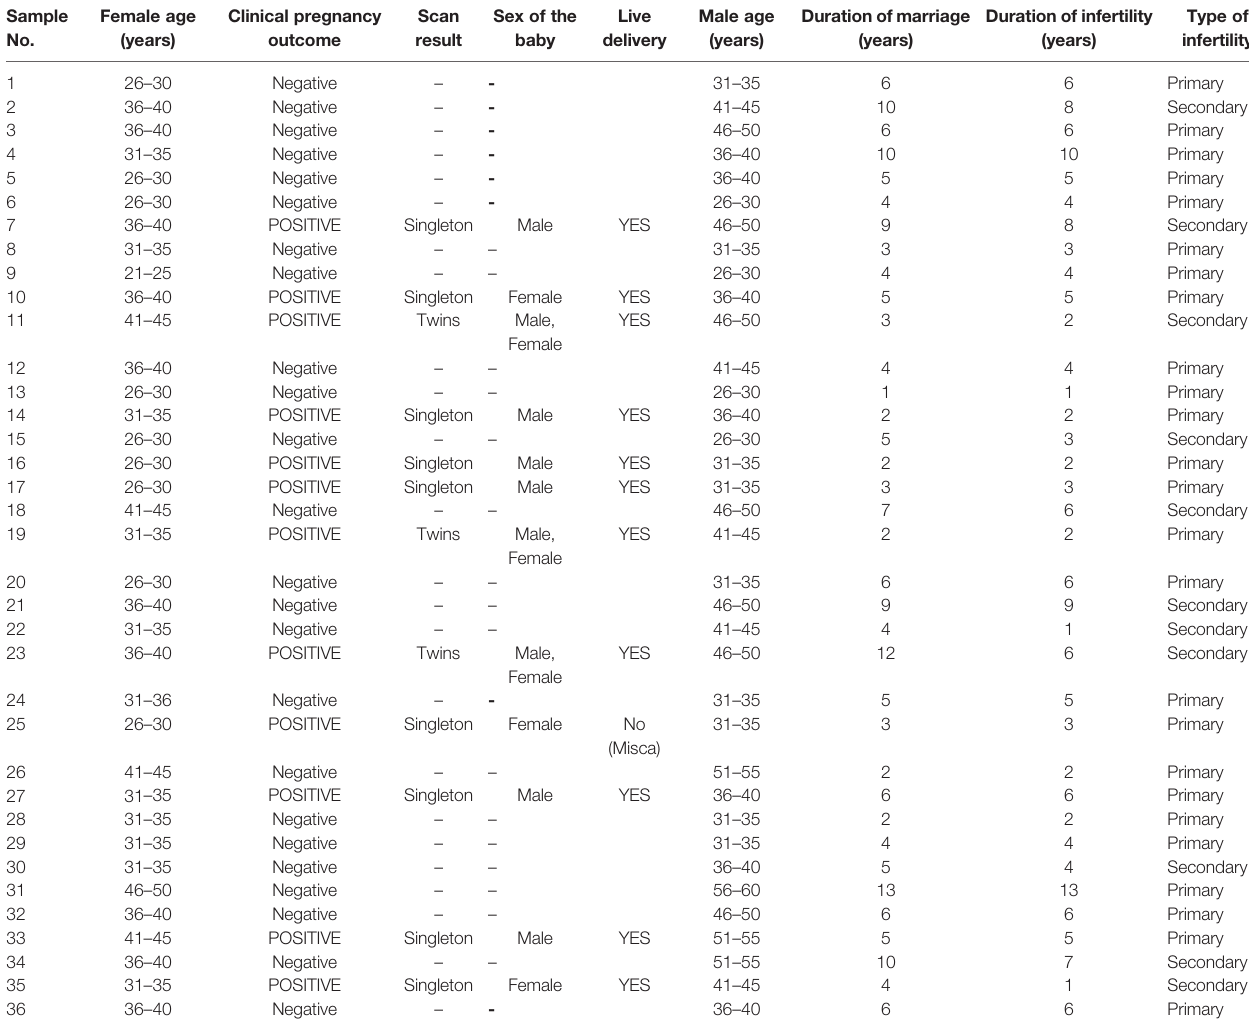
TABLE 1A | Demographic information and IVF clinical outcome. Sample